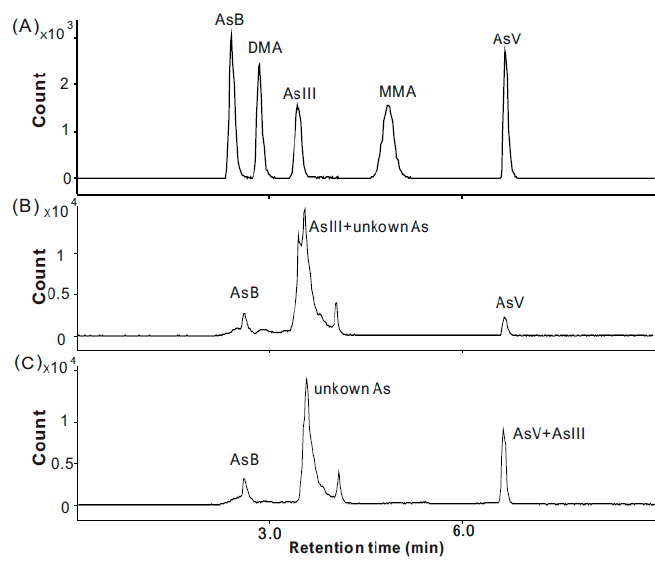
Figure 4. Chromatograms obtained in quantification by HPLC-ICP-MS. ( A ) A mix of standard samples of AsB, DMA V , As III , MMA, and As V , at 10 ppb of each arsenic species. ( B ) The extracts of sample NQ1. The As III and unknown organic As peaks overlap. ( C ) Oxidation products of the extracts of NQ1. Any As III is transformed into As V when H 2 O 2 is added to the